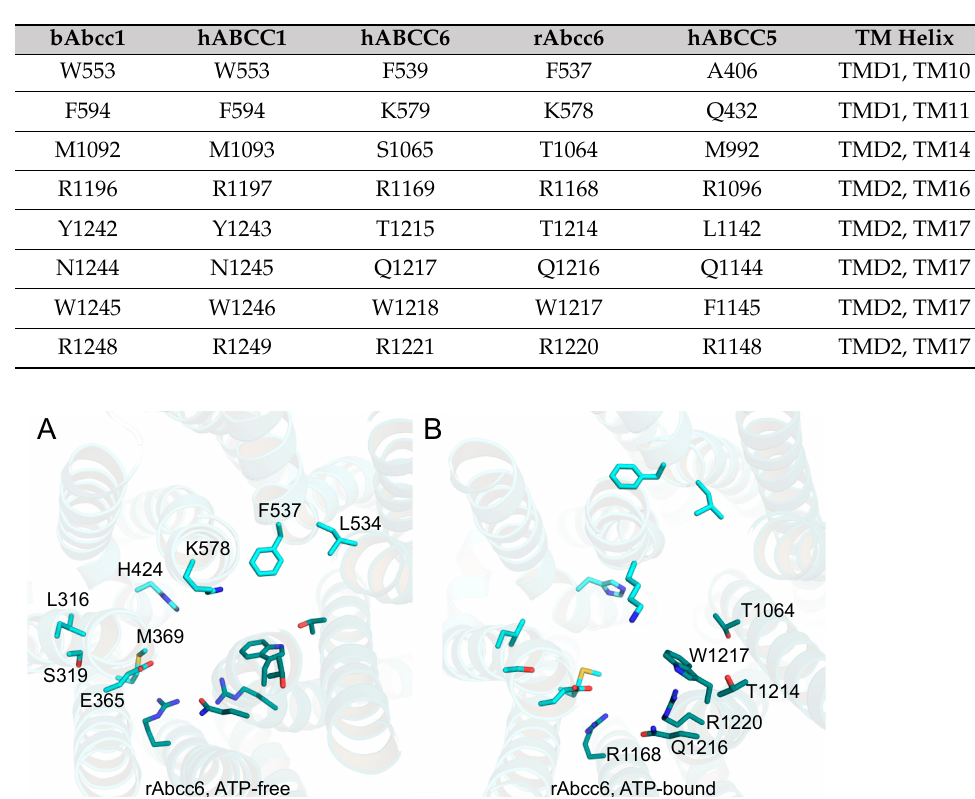
Figure 2. rAbcc6 residues in the transmembrane cavity corresponding to those in the bAbcc1 cavity surrounding LTC 4 . View from the extracellular side of the transmembrane cavity of the inward-facing, ATP-free ( A ) and outward-facing, ATP-bound ( B ) models of rAbcc6. The residues corresponding to those of the bAbcc1 LTC 4 binding cavity are shown as sticks in light cyan for TMD1 and in teal for TMD2.